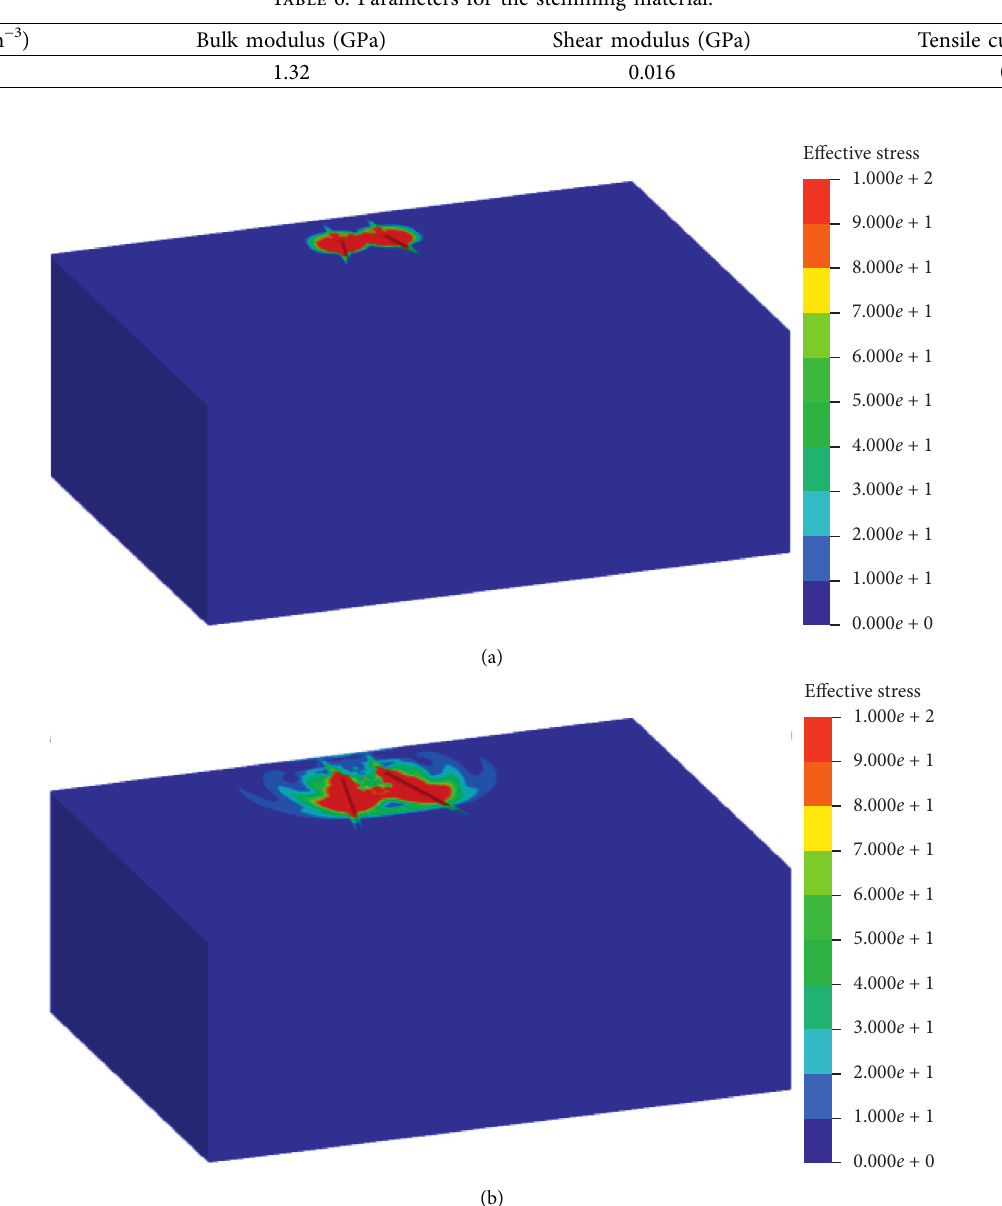
Table 6: Parameters for the stemming